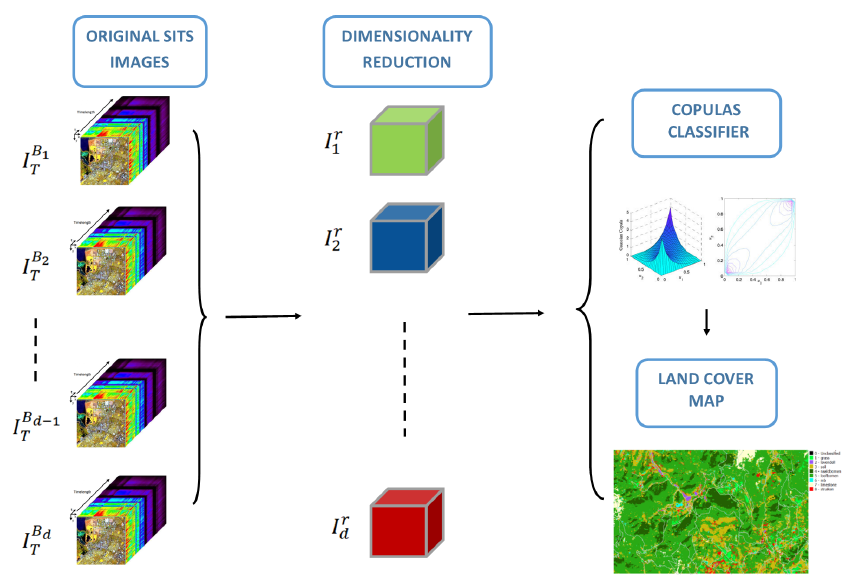
Figure 2. Visual representation of the Cop CLF Learning workflow. All of the SITS bands I B 1 are considered, and the result is the reduced images I r The stack of these images is used to train the copula classifier after having properly split